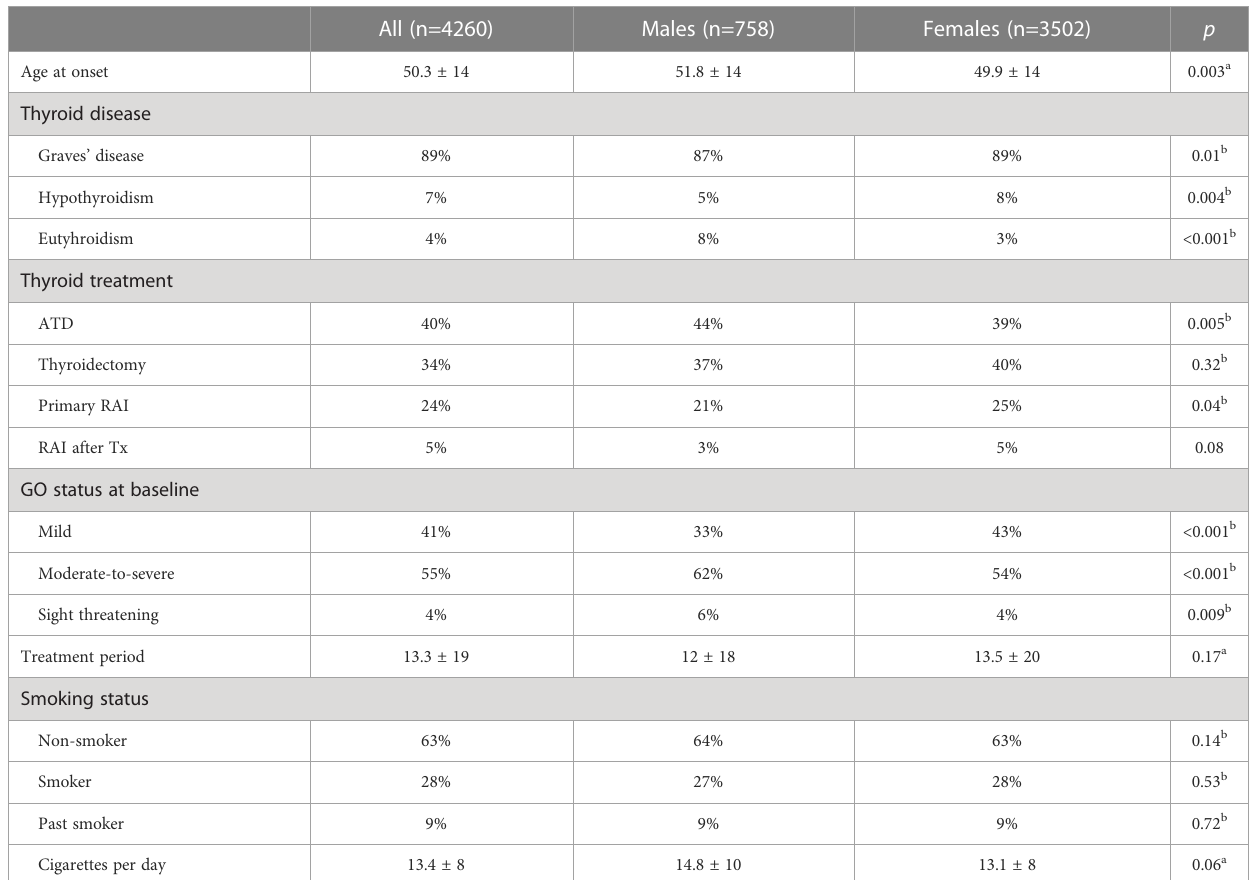
TABLE 1 Characteristics of study